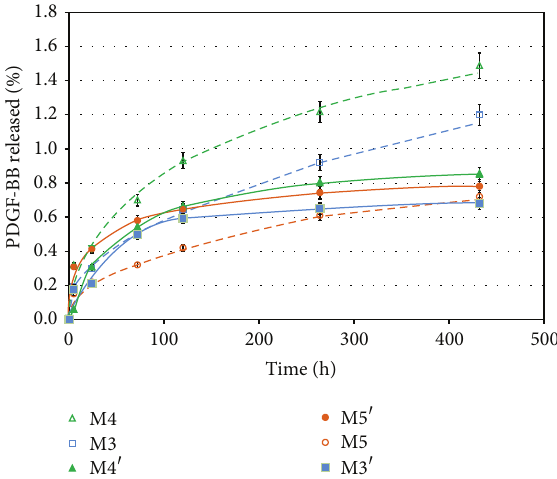
Figure 9: Release profile of PDGF-BB from composite membranes: with amoxicillin M3 󸀠 MCCh: Fb = 2 :1, M4 󸀠 MCCh: Fb = 1:1, and M5 󸀠 MCCh:Fb = 1 :2, and without M3 MCCh:Fb = 2 :1, M4 MCCh:Fb = 1:1, and M5 MCCh:Fb =